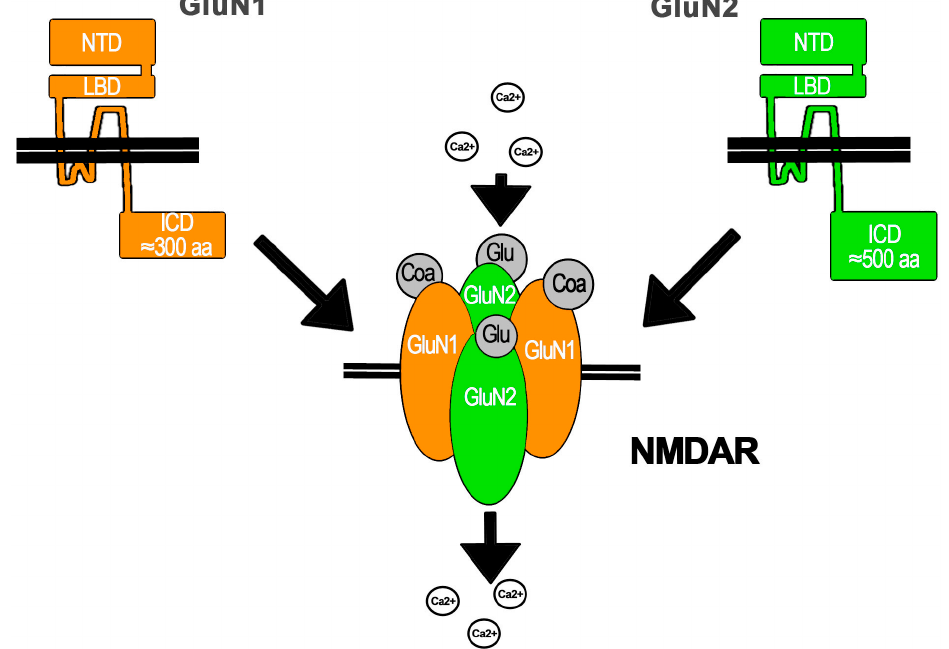
Figure 1. General structure of N-methyl- D -aspartate (NMDA) receptor (NMDAR). The NMDAR is assembled with GluN subunits, of which two GluN1 units are obligate. NMDAR subunits have the same general structure with NTD, LBD, IC domain, and three transmembrane helices with two loops, the IC that re-enters into de cell membrane. Glu binds GluN2 subunits, whereas Gly or D -Ser bind GluN1 (or GluN3; not shown) subunits. After agonist and co-agonist binding and Mg2+ release by membrane depolarization, the channel opens and enables Ca2+ flow (for details, see text).